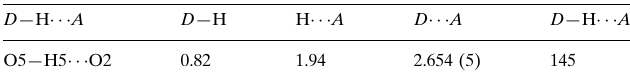
Hydrogen-bond geometry (A˚ , (cid:3)